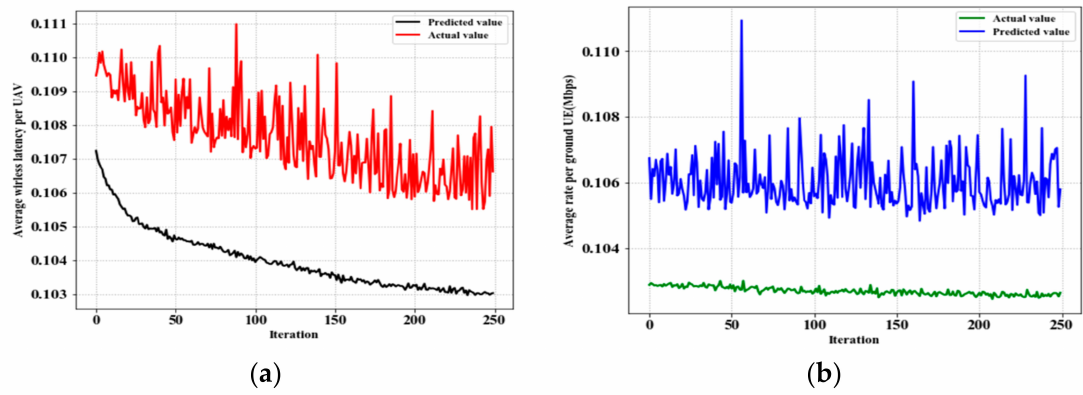
Figure 9. Performance analysis of average throughput and power rates: ( a ) average throughput delay from the UAV and ( b ) data access rate per ground user equipment as compared to various iterations.